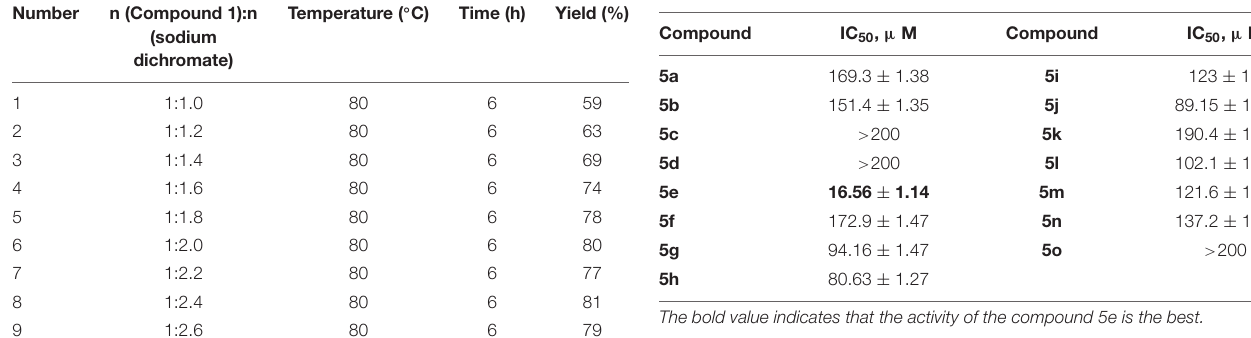
TABLE 3 | Data of the inhibitory effect of compounds 5a – 5o on lung cancer cell